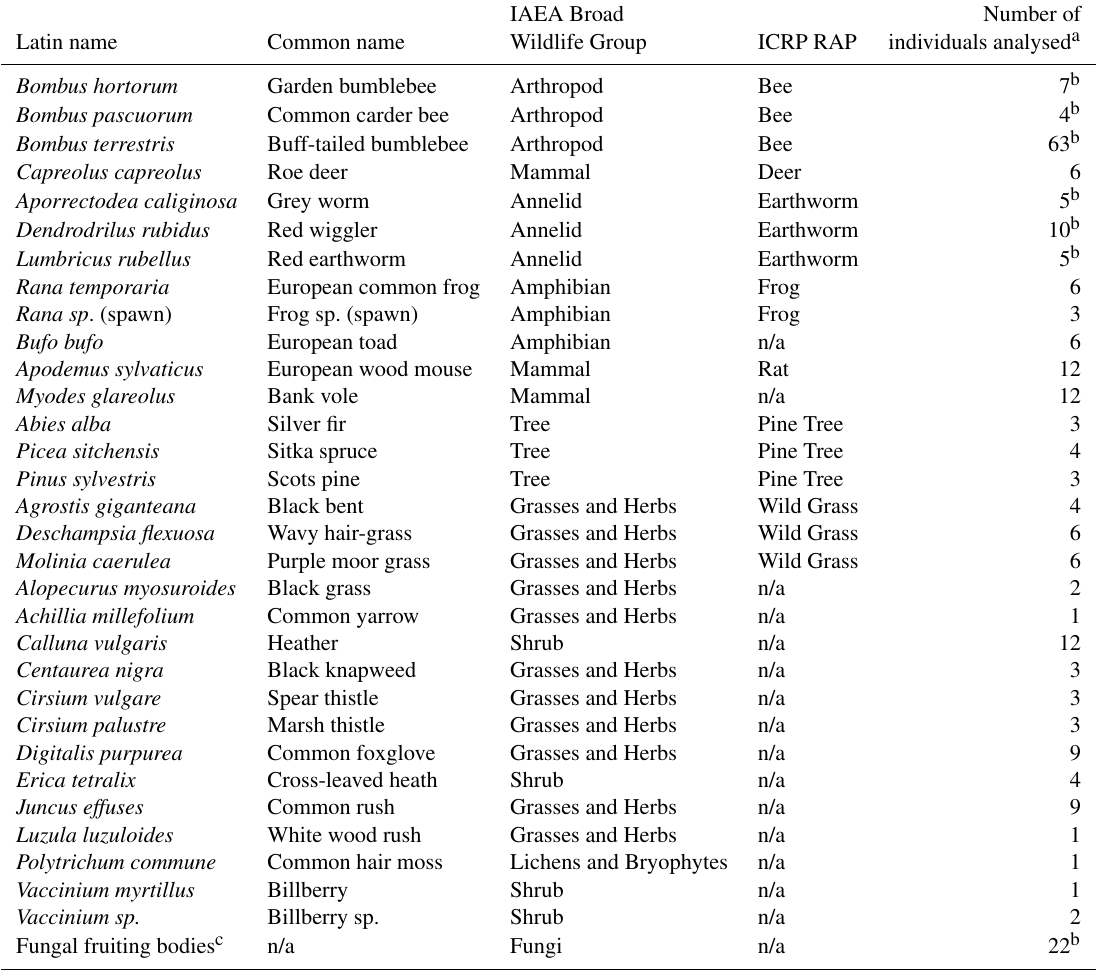
Table 1. Species sampled and analysed during this